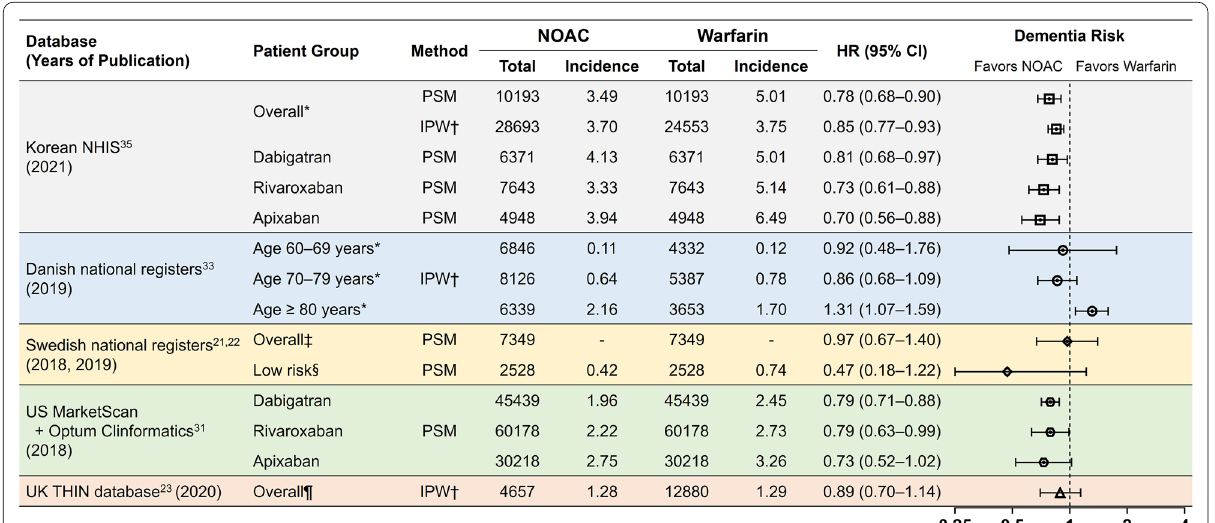
Fig. 3 Risk of dementia according to oral anticoagulant regimens in data from Asian, European, and North American populations. CI confidence interval, HR hazard ratio, IPW inverse probability of treatment weighting, NHIS National Health Insurance Service, PSM propensity score matching, THIN The Health Improvement Network. Incidences were presented as rates per 100 person‑years. *Includes dabigatran, rivaroxaban, and apixaban users. †Incidences and hazard ratios were propensity weighted. ‡Types of NOAC and incidences of dementia were not presented in the article. §CHA 2 DS 2 ‑VASc 0 (male) or 1 (female). ¶ Includes dabigatran, rivaroxaban, apixaban, and edoxaban